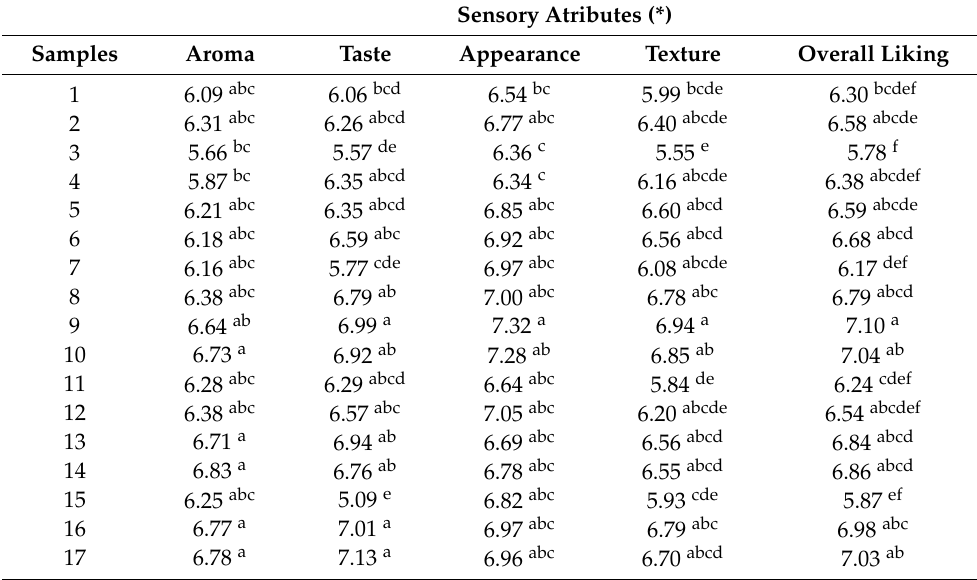
Table 3. Murici and tapereb á blend beverages sensory analysis results. Sensory Atributes